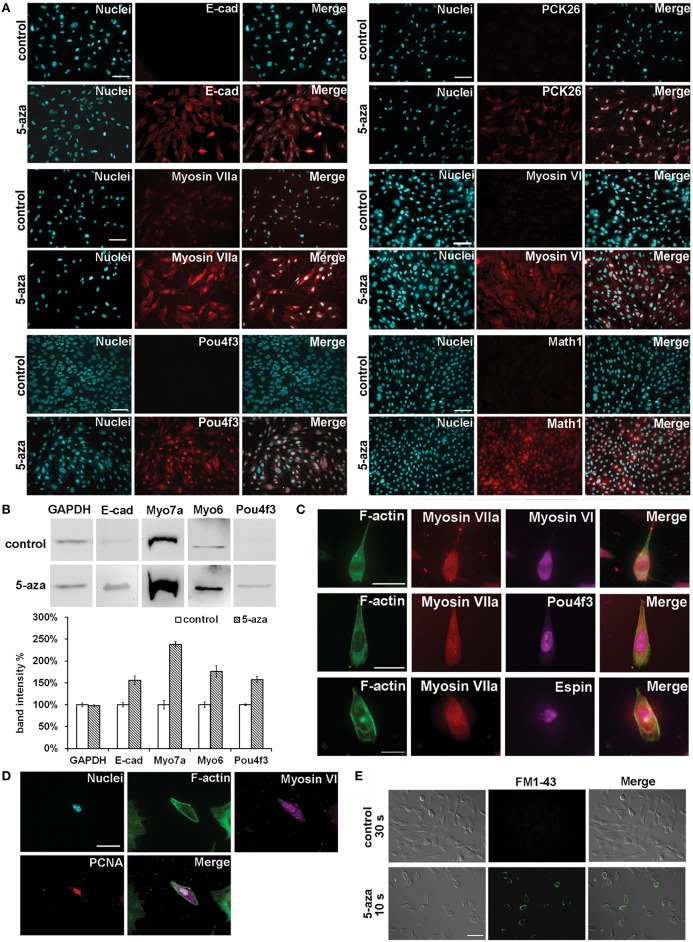
Hair cell protein expression changes following 5-aza treatment. (A) Immunofluorescence showed up-regulated expression of epithelial hair cell markers E-cad, PCK26, Myosin VIIa, Myosin VI, Math1, and Pou4f3 in treated MUCs (Scale bar 100 μm). (B) Western blotting showed significant increased expression of Myosin VIIa and Myosin VI, and slightly up-regulation of E-cad and Pou4f3 in treated MUCs. (C) Multiple-labeling immunofluorescence showed that newly-generated hair cell-like cells were double-labeled with Myosin VIIa and Myosin VI, Myosin VIIa and Pou4f3, and Myosin VIIa and Espin (scale bar 50 μm). (D) Hair cell-like cells were PCNA and Myosin VI positive, suggesting that these cells were newly-generated cells (scale bar 50 μm). (E) In initial optical assay using FM1-43 permeation test, control MUCs did not show FM1-43 signal after 30 s incubation. In treated MUCs, ~30% of treated MUCs were filled with FM1-43 when they were exposed to FM1-43 for 10 s at room temperature (scale bar 100 μm).